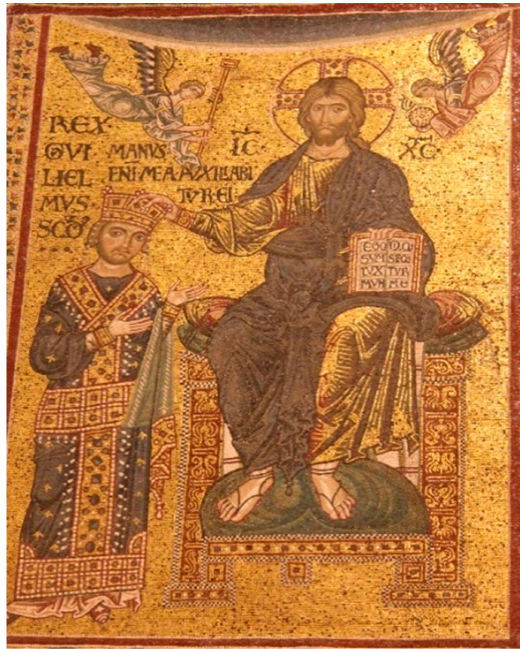
Figure 6. Christ Crowning William II , mosaic, 1177–1183. Monreale, Cathedral, choir. Photo